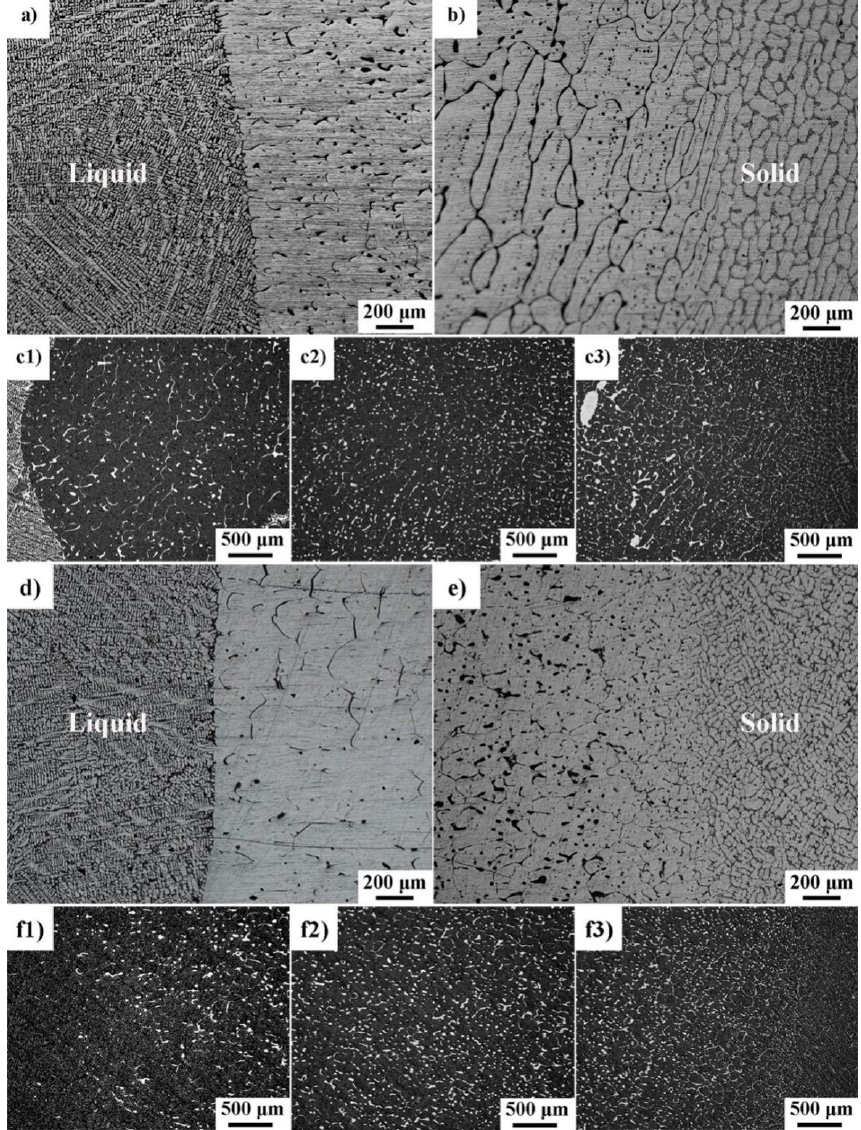
Figure 2. The microstructure of Al - 1.5 wt%Ni alloy solidified under different high pressures . ( a – c3 ) 1 GPa; ( d – f3 ) 3 GPa.